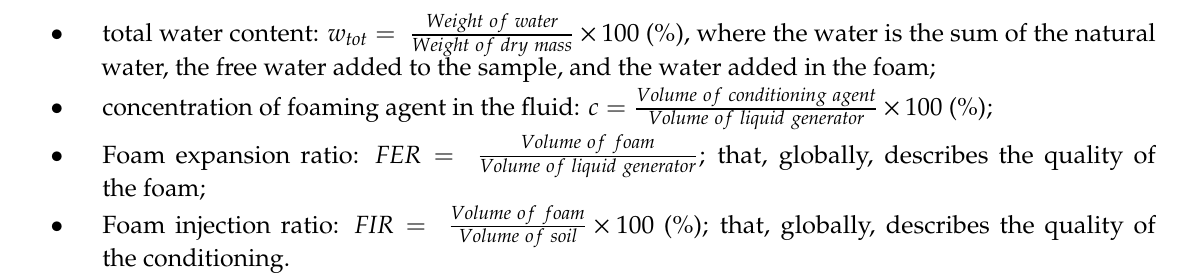
Table 1. Conditioning set parameters for the three studied conditioning agents.